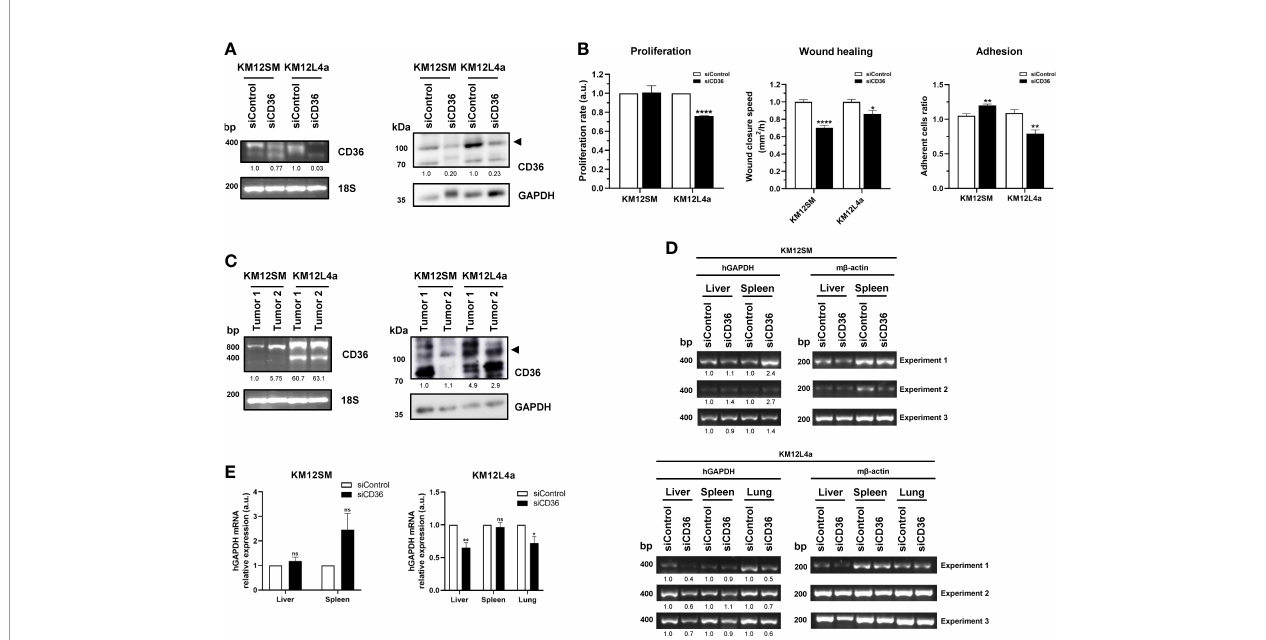
FIGURE 8 | In vitro and in vivo effect of CD36 depletion in the tumorigenic and metastatic properties of KM12SM and KM12L4a cells or derived tumours. (A) Evaluation by PCR and WB of the transient silencing of CD36 after 48 h post-transfection in KM12SM and KM12L4a cell lines. As control, we transfected the cell lines with a scramble siRNA. By PCR, 18S was used as internal control. By WB, GAPDH was used as loading control. (B) Proliferation, wound healing, and adhesion properties of KM12SM and KM12L4a transiently transfected with CD36 siRNA in comparison to scramble siRNA were investigated, showing that CD36 plays a role in the tumorigenic and metastatic properties of metastatic colorectal cancer cell lines. (C) Analysis of the CD36 mRNA and protein expression levels in actual metastatic tumoral samples (n = 2) derived from KM12SM and KM12L4a cells. By PCR, 18S was used as internal control. By WB, GAPDH was used as loading control. (D) Nude mice intrasplenically inoculated with KM12SM or KM12L4a cells transiently transfected with siScramble and CD36 siRNA were sacri fi ced 24 h after inoculation for analysis of in vivo liver and lung homing (n = 3). RNA was isolated from the liver, lung, and spleen (as control) and directly subjected to RT-PCR to amplify human GAPDH (hGAPDH). Murine b -actin (m b -actin) was ampli fi ed as control. (E) Statistically signi fi cant lower mRNA levels of hGAPDH were found for liver and lung homing of KM12L4a cells. (A – D) mRNA or protein abundance was quanti fi ed by densitometry using ImageJ, and data were normalized with the expression levels of 18S or m b -actin for mRNA and GAPDH for protein abundance. * p value < 0.05; ** p value < 0.01; **** p value <